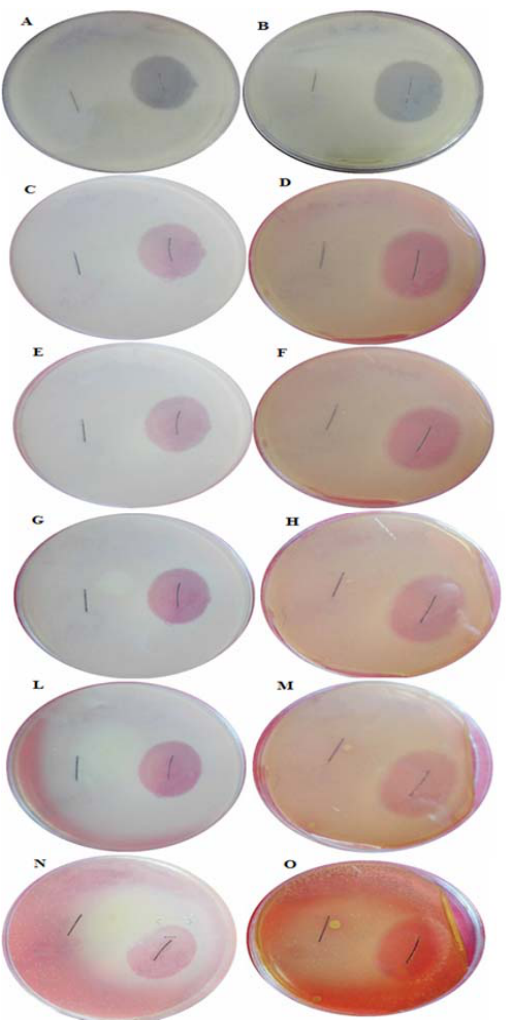
Fig. 3: Antimicrobial activity of CFX@PVA silk sutures. A,C,E,G,L, N show sustained efficacy assay against S. aureus and B,D,F,H,M and O show sustained efficacy assay against E. coli , on the day 1, 3, 5, 7,10, and 15, respectively.